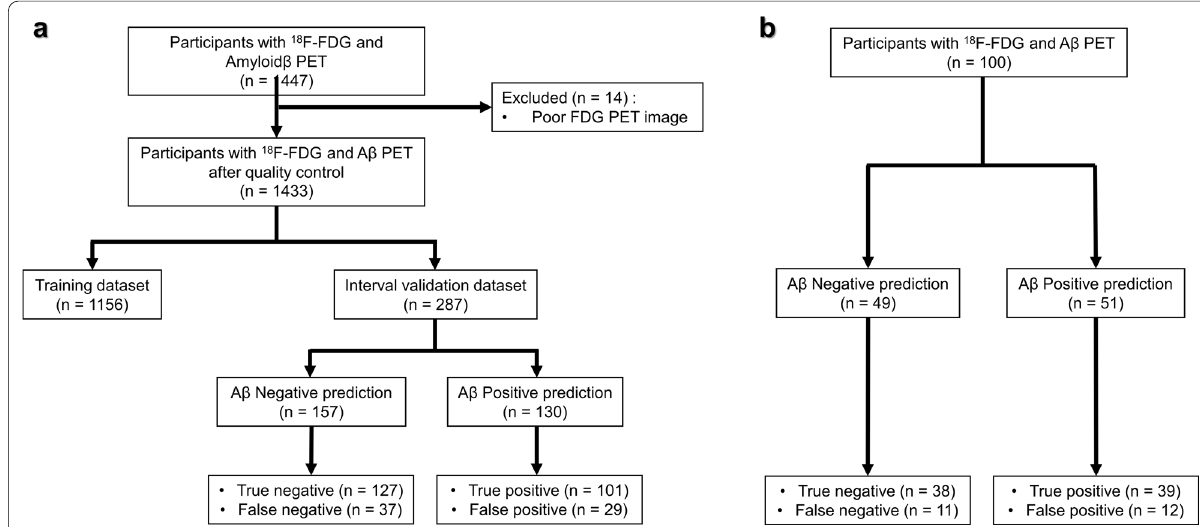
Fig. 1 Flowchart of participants through the study for the a training and interval validation datasets, as well as b the external validation dataset.